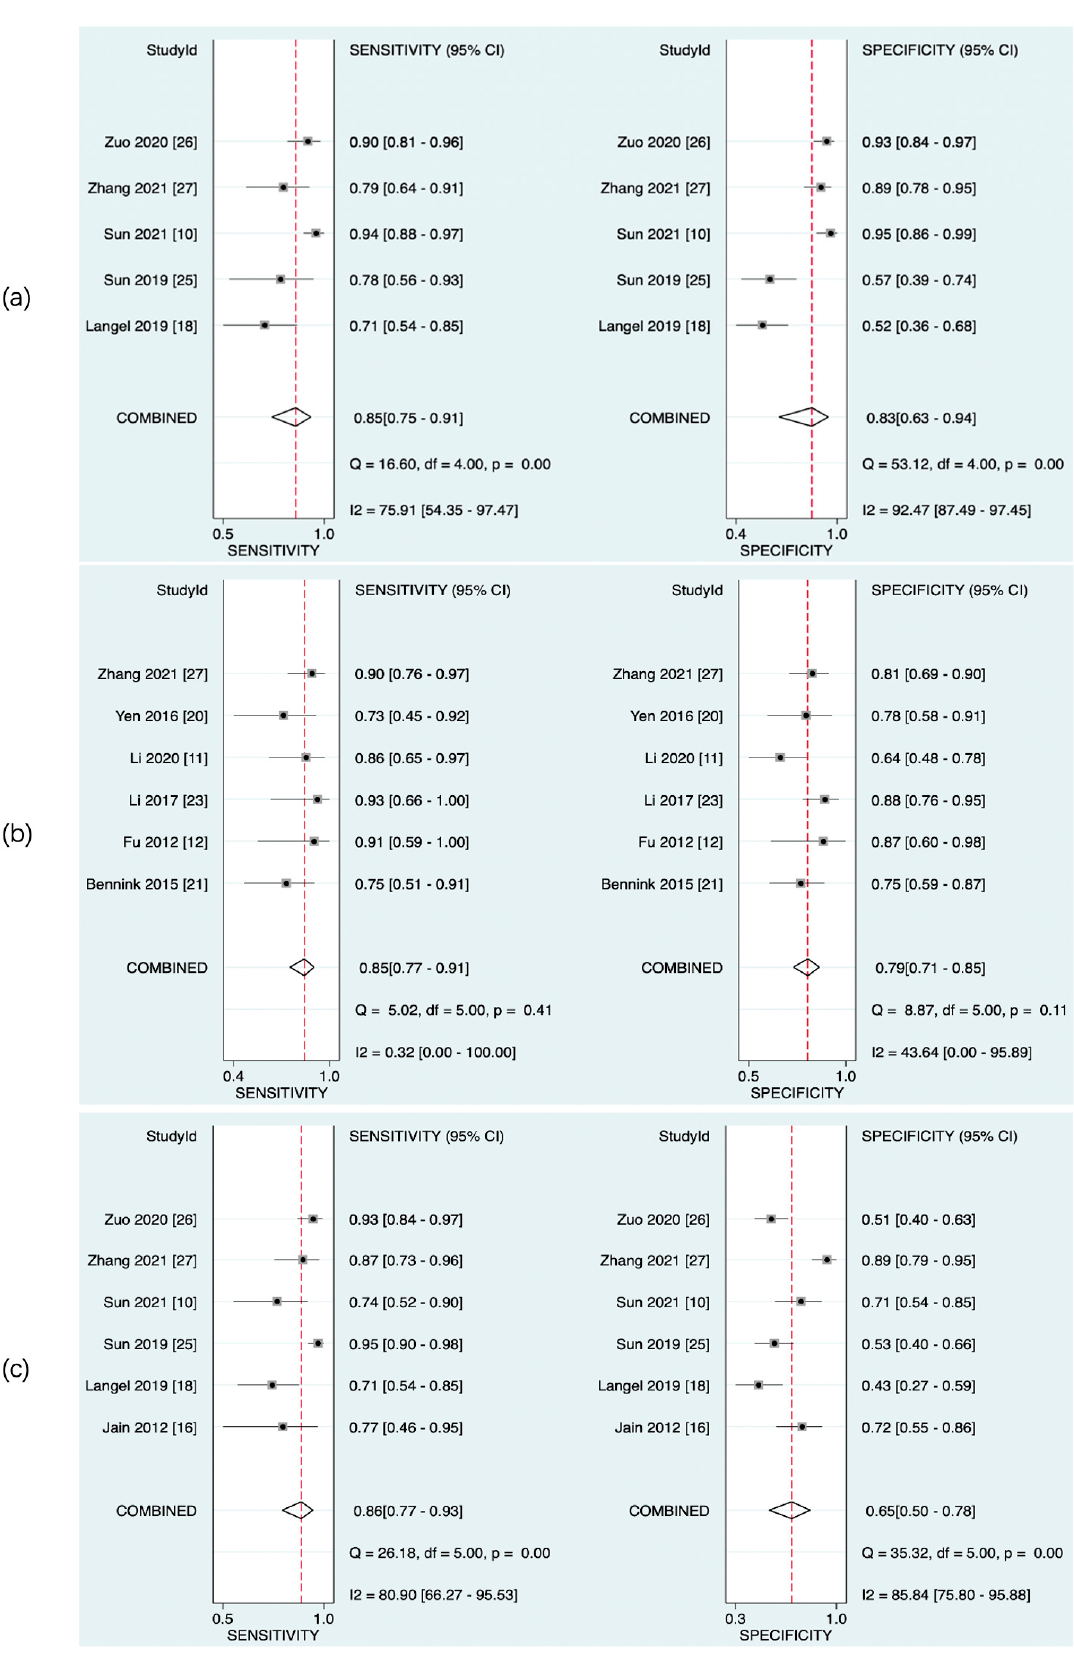
Figure 7. Pooled sensitivity and specificity of CTP parameters for diagnosis of HT. rCBF ( a ), rPS ( b ), and rCBV ( c ).